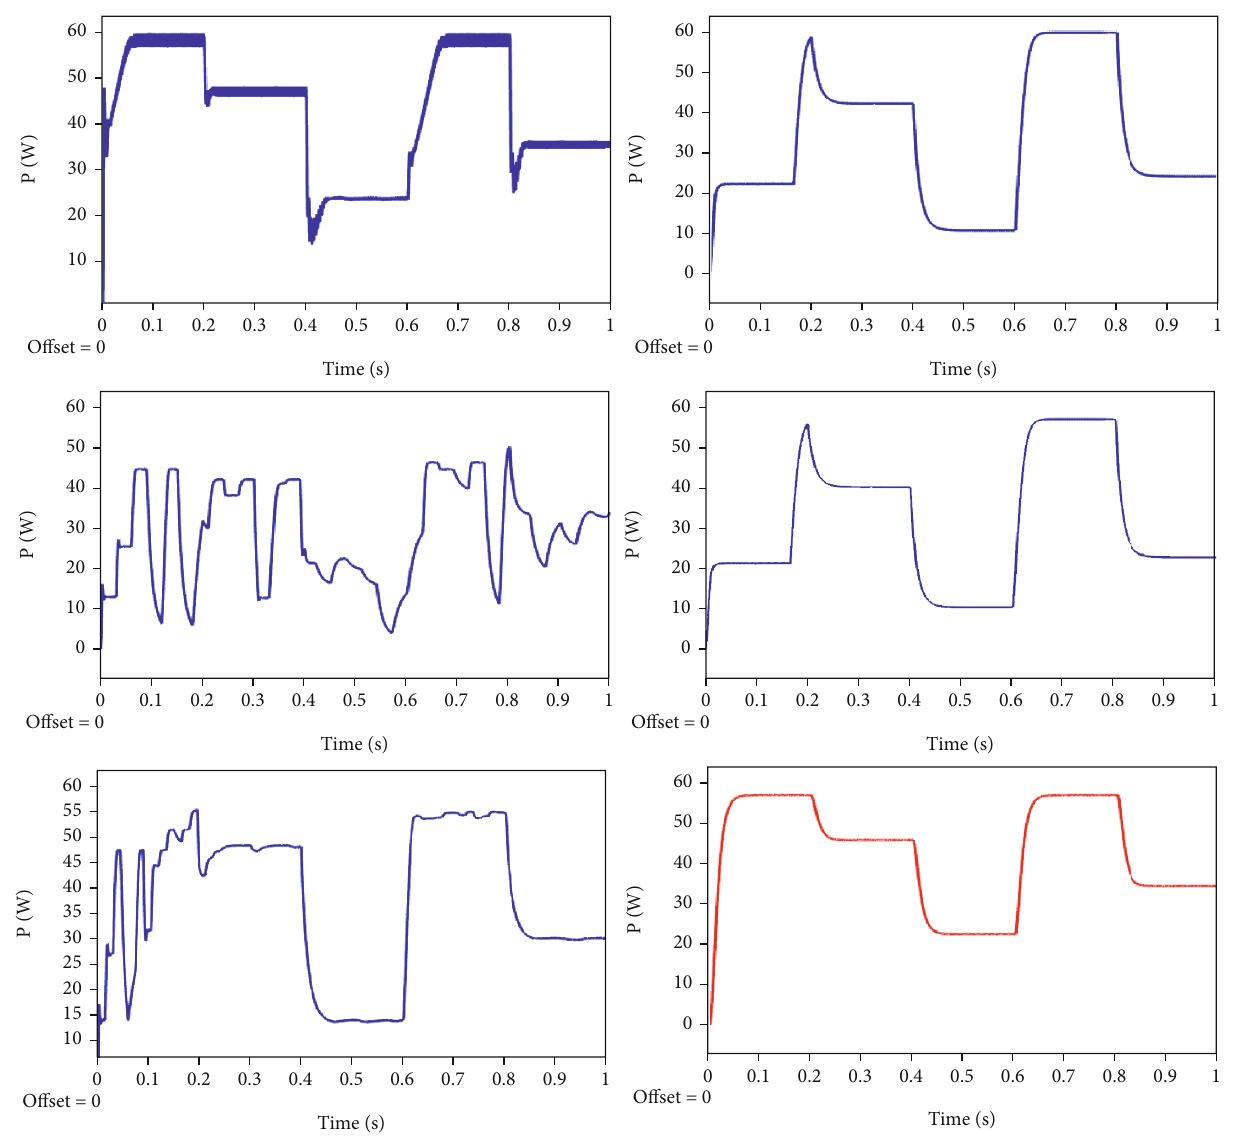
Figure 9: Simulation waveforms at the rapid change in insolation at before 1 s. PV array output power P&O, PSO, CUCKOO, GWO, WOA, and SMC-PSO.